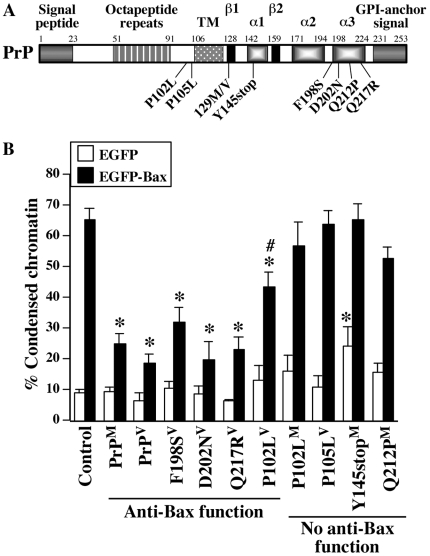
GSS-associated PrP mutants F198SV, D202NV, P102LV and Q217RV, but not P102LM, P105LV, Y145stopM, and Q212PM, prevent Bax-mediated condensed chromatin in MCF-7 cells.A. Schematic diagram of human PrP showing the signal peptide, the octapeptide repeats, the transmembrane domain (TM), the β-sheets (β1 and β2), the α-helices (α1, α2, α3), the glycosyl phosphatidylinositol (GPI)-anchor signal peptide, the polymorphic codon at amino acid 129, and the GSS PrP mutations. B. Percentage of cell death assessed by condensed chromatin in MCF-7 cells transfected with pBud-EGFP or pBud-EGFP-Bax (control), pBud-EGFP/PrP or PrP mutants, and pBud-EGFP-Bax/PrP or PrP mutants carrying a methionine (M) or a valine (V) at codon 129. Data represent the mean±SEM of six independent experiments. At least 600 cells were counted for each condition. * and # indicate a statistically significant difference (p≤0.05) compared to the control and wild type PrP, respectively.